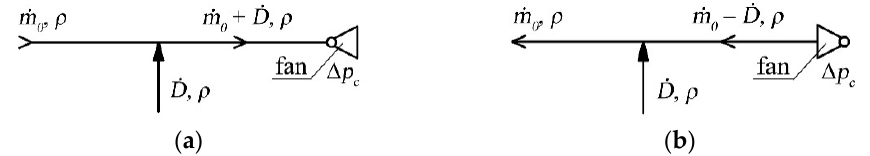
Figure 1. Gas flow chart for Case 1 under consideration: ( a ) fan working in the suction mode, ( b ) fan working in the blowing mode.